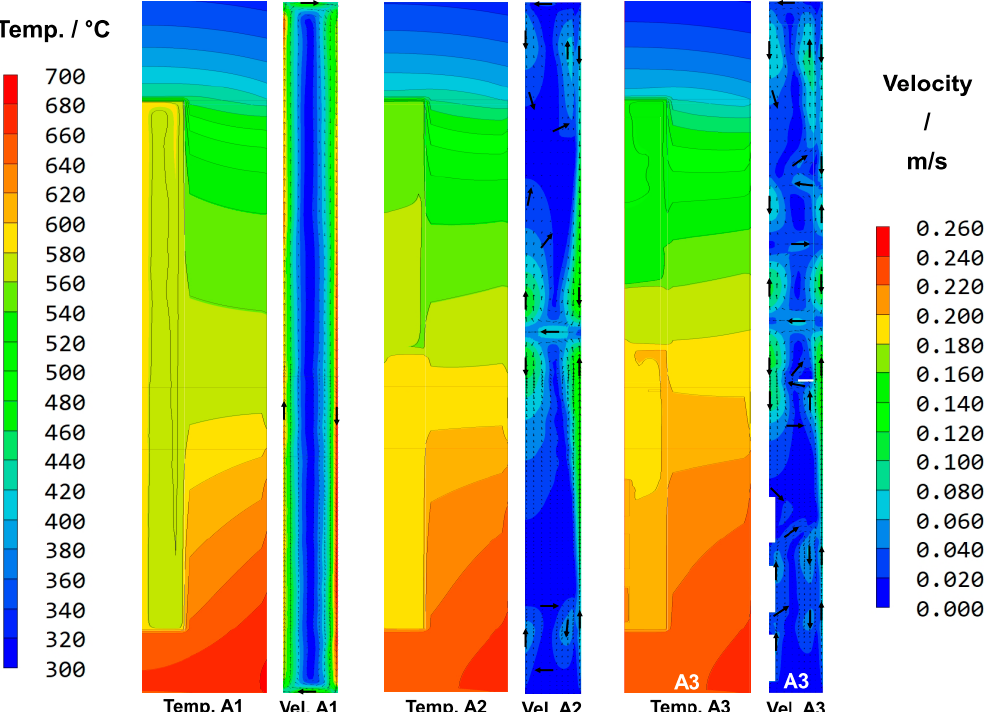
Figure 9. Close-ups showing the temperature distribution in the walls and interior of the autoclave (left subfigure of each case) and velocity distribution inside the autoclave (right subfigure of each case). For better visibility, thick arrows were added as guides to the eye.